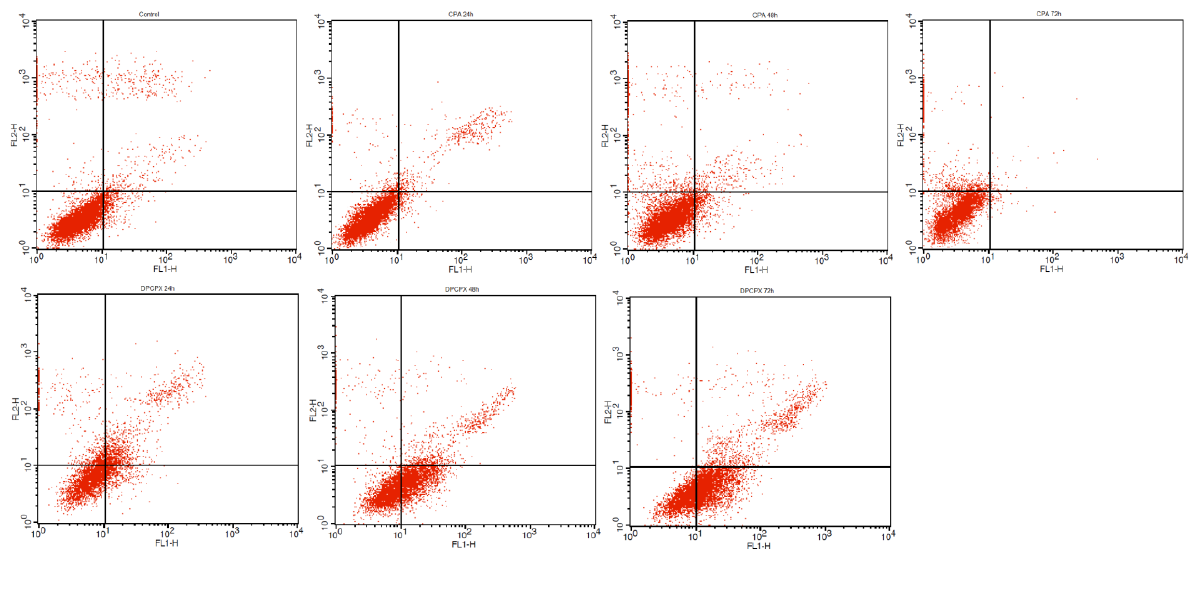
Figure 3. Rate of Apoptotic Cells in T47D Breast Cancer Cell Lines Treated With 87 nM Antagonist of the A1 Receptor (DPCPX) and 180 μM. Note . The agonist of the A1 receptor (CPA) according to inhibitory concentration (IC50) for different times is displayed in Figure 3 and untreated t47D cells were used as control groups as